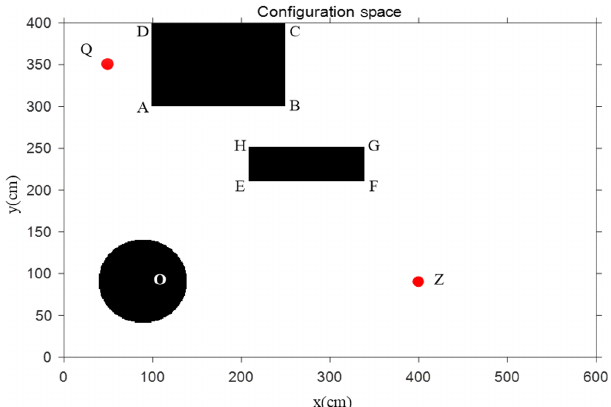
Figure 8. Schematic diagram of environmental obstacles.